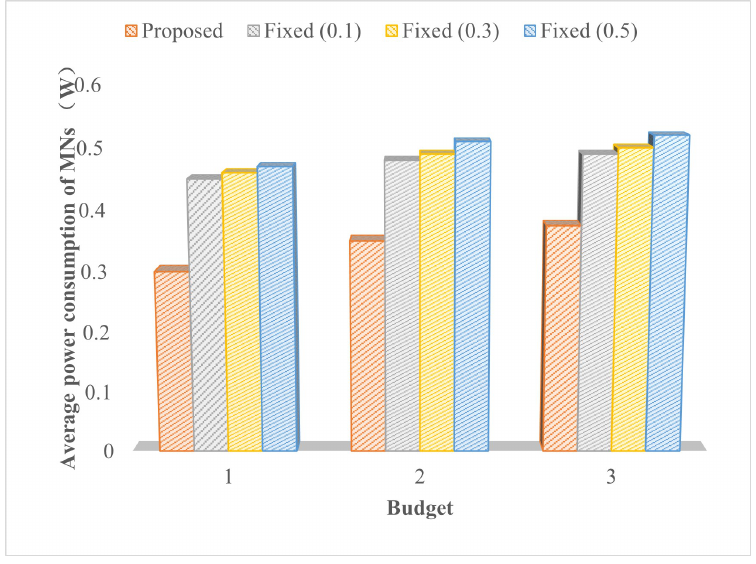
Figure 6. Power consumption vs. monetary